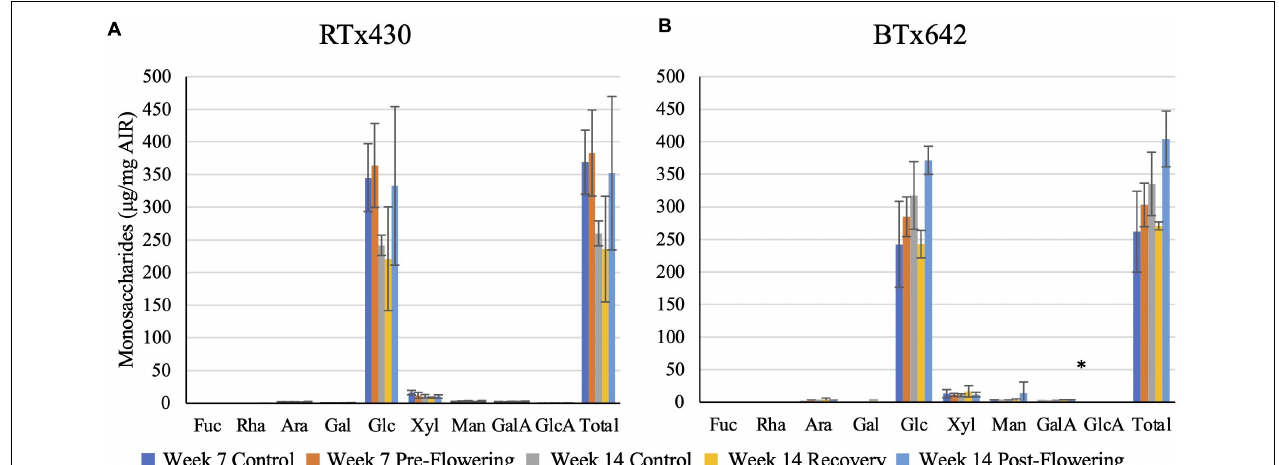
FIGURE 3 | Cellulosic monosaccharide composition analysis. Monosaccharides released from a sulfuric acid hydrolysis of AIR already treated with TFA (matrix monosaccharides removed) from leaves (A,B) . Data represents mean ± SD of three biological replicates per condition per genotype where biological replicates themselves consist of ten pooled plants from the same planting block. Asterisk indicate p < 0.05 determined by Student’s t -test with the Benjamini–Hochberg